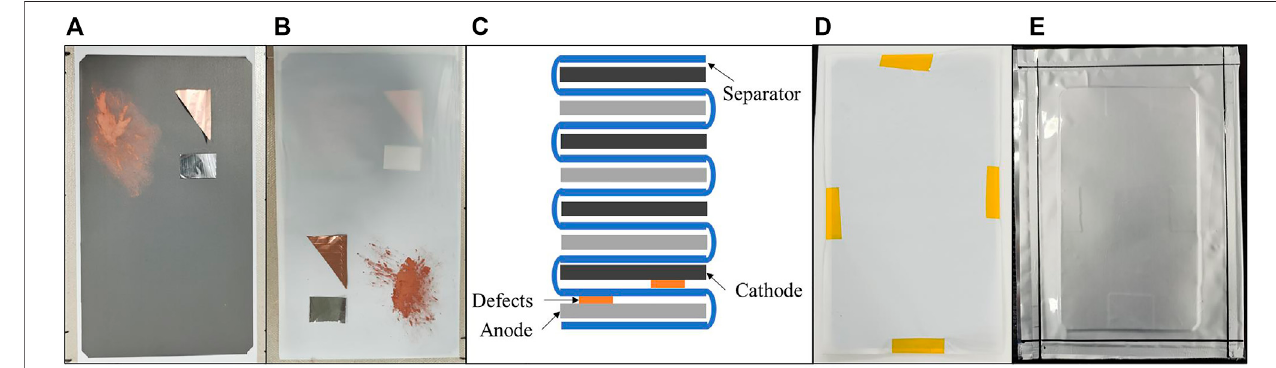
FIGURE 1 | Internal structure of defective battery sample.